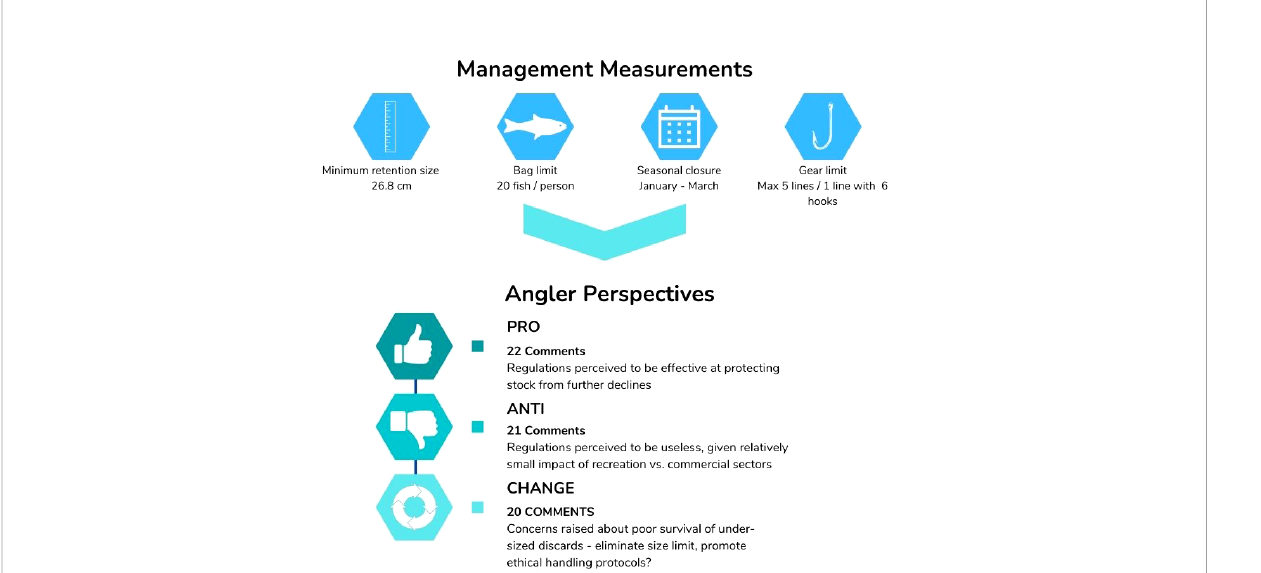
FIGURE 4 Summary of current restrictions and angler perspectives on current management measures (2021-2022) for recreational Atlantic mackerel or Amalamaq ( Scomber scombrus ) fi shing in Nova Scotia/Mi ’ kma ’